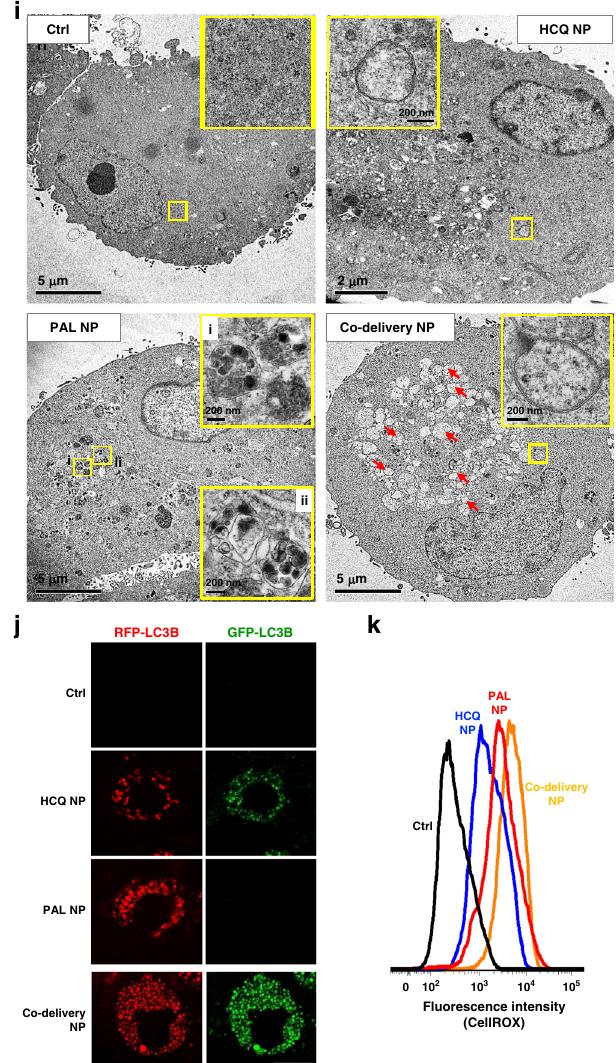
Fig. 2 Development of ratiometric nanoformulation for the co-delivery of PAL and HCQ. a Schemes depicting the structure of lipid-coated MSNP nanocarrier and the mechanism for simultaneous remote loading of PAL and HCQ using a trapping agent. TEA 8 SOS-laden particles were incubated with the solution of PAL and HCQ mixed at prede fi ned molar ratios, allowing the amphipathic drugs to diffuse across the lipid bilayer for protonation by TEA 8 SOS. b Preparation of co-delivery nanocarriers with various PAL/HCQ ratios. c BrdU proliferation assay to calculate IC 50 and CI for co-delivery nanoparticles. Each concentration was tested in triplicate ( n = 3). Co-delivery formulation with PAL/HCQ feed molar ratio of 1:5 (loading ratio of 1:4.3) displayed the best level of synergy and has been chosen for the following study (red arrow). d Summary of physiochemical properties of co-delivery NP. CryoEM of co-delivery NP suggested intact lipid bilayer coating and uniform size distribution. Scale bar: 100 nm. e Crystal violet staining to visualize the growth-inhibitory effect in PANC-1 cells incubated with co-delivery NP for 72 h with equivalent concentration (PAL = 2.5 μ M, HCQ = 10.8 μ M). f Co- delivery NP signi fi cantly improved the anti-proliferative effect compared to PAL NP ( p = 5.7 × 10 − 4 ). Six ROIs were analyzed for the Ki67 expression ( n = 6). g Cell cycle analysis using fl ow cytometry (triplicate). Both PAL NP and co-delivery NP induced signi fi cant G1 cell cycle arrest compared to control with p values of 3.3 × 10 − 4 and 1.2 × 10 − 4 , respectively. h Western blot to re fl ect the impact on the expression of phospho-Rb and total Rb. i Representative TEM characterization of autophagic vacuoles in PANC-1 cells. j GFP-RFP-LC3B reporter assay ( n = 6 ROIs) to visualize and compare the intracellular level Supplementary Fig. 7D. k ROS production probed by CellROX staining suggested that the autophagy blockade by co-delivery NP was ROS mediated. One of the two independent repetitions with similar results is shown here for b – k . Data represent mean ± SD; statistical difference was evaluated by one-way ANOVA followed by Tukey ’ s post hoc test (* p < 0.05). Source data are provided as a Source Data fi